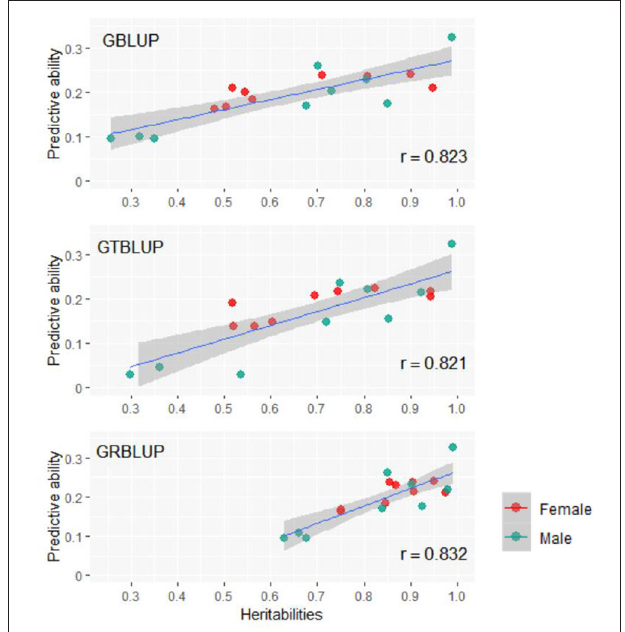
FIGURE 4 | The correlation between heritabilities ˆ h 2 G , ˆ H 2 GT , ˆ H 2 GR , and predictive abilities for GBLUP, GTBLUP, and GRBLUP across all traits and both sexes. r denotes the Pearson correlation coefficient. The blue lines denote the overall linear regression lines. The gray shadow denotes the 0.95 confidence